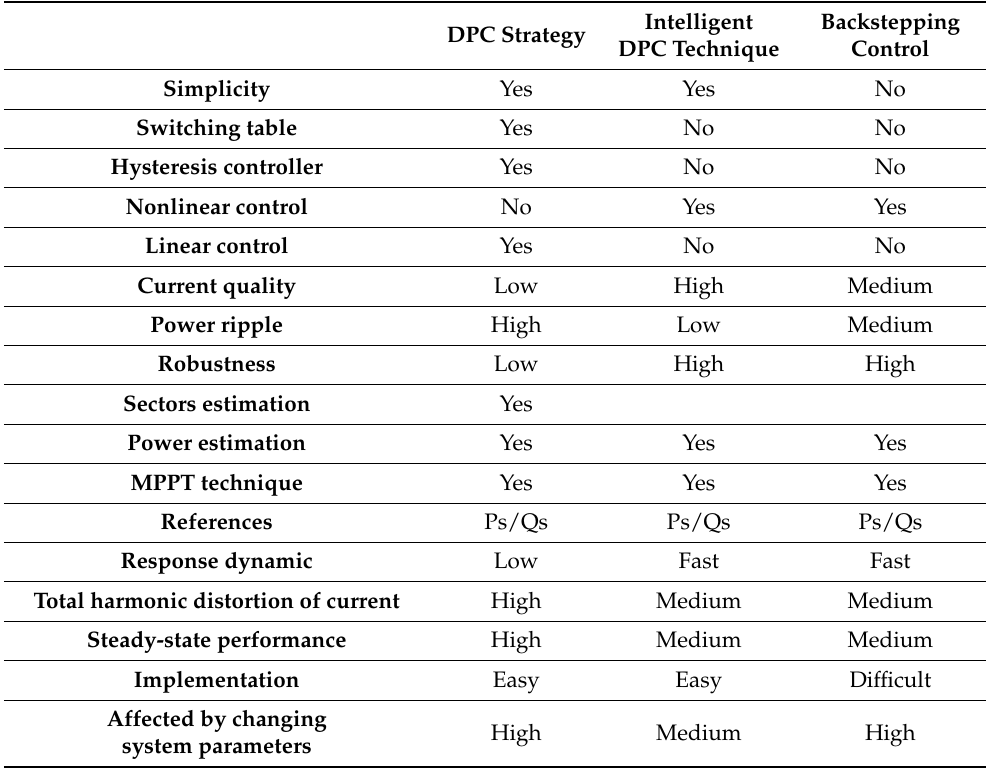
Table 3. Comparison of the proposed methods.